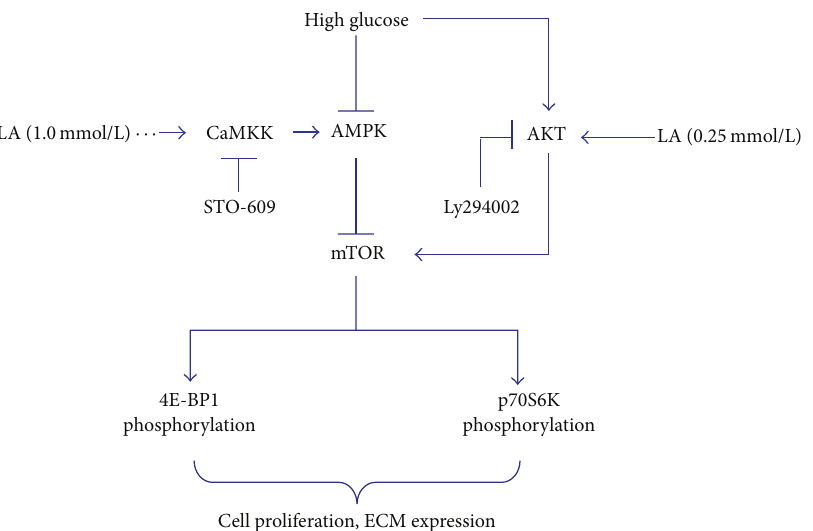
Figure 9: Schematic of the molecular mechanism that LA regulated high glucose-induced mesangial cell proliferation and extracellular matrix